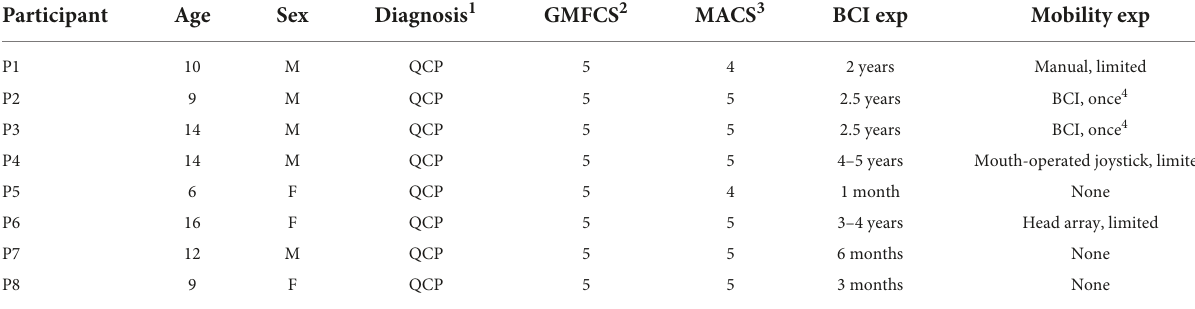
TABLE 2 Participant information.